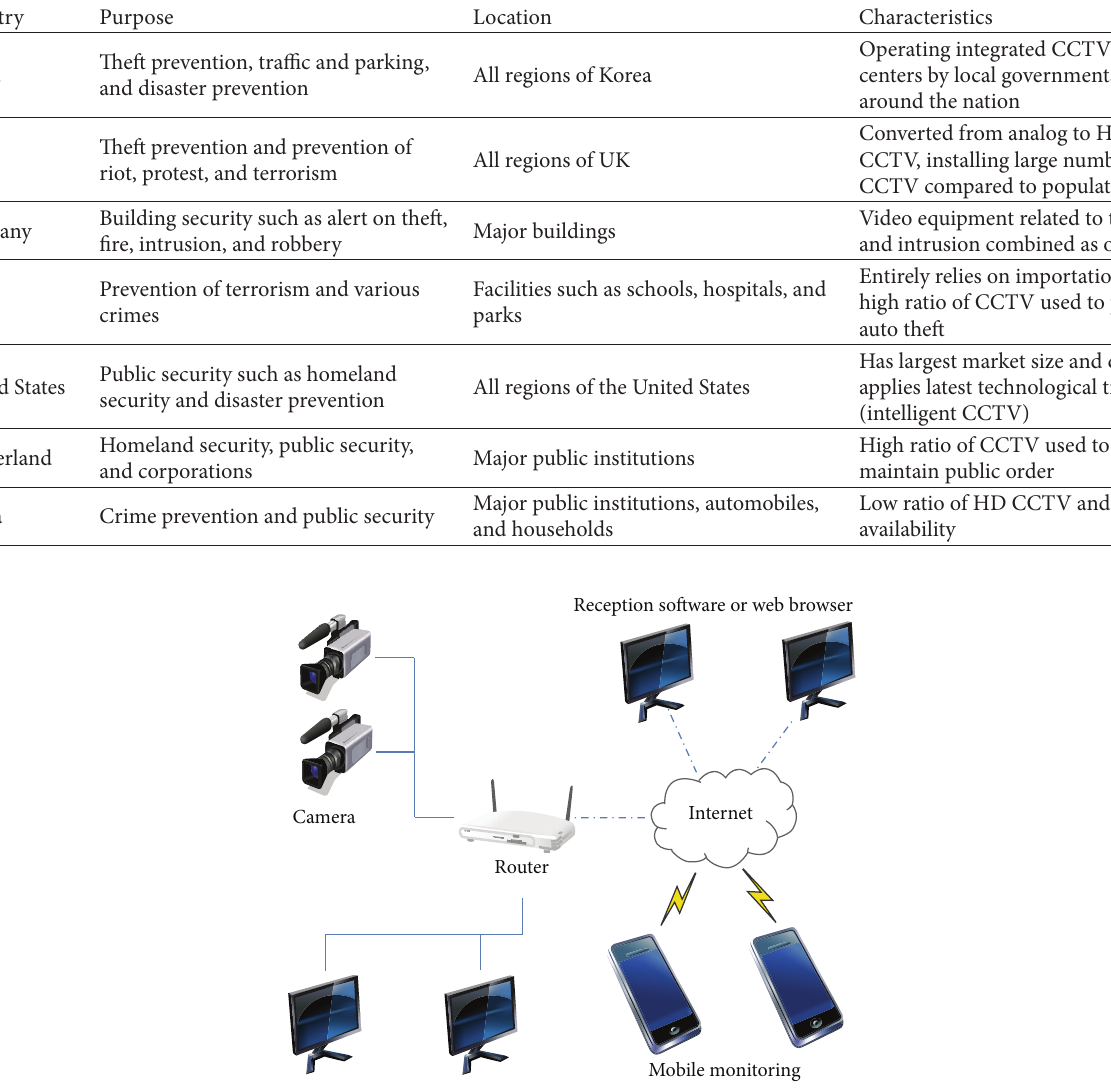
Table 1: International trends of CCTV security (purpose and characteristics).